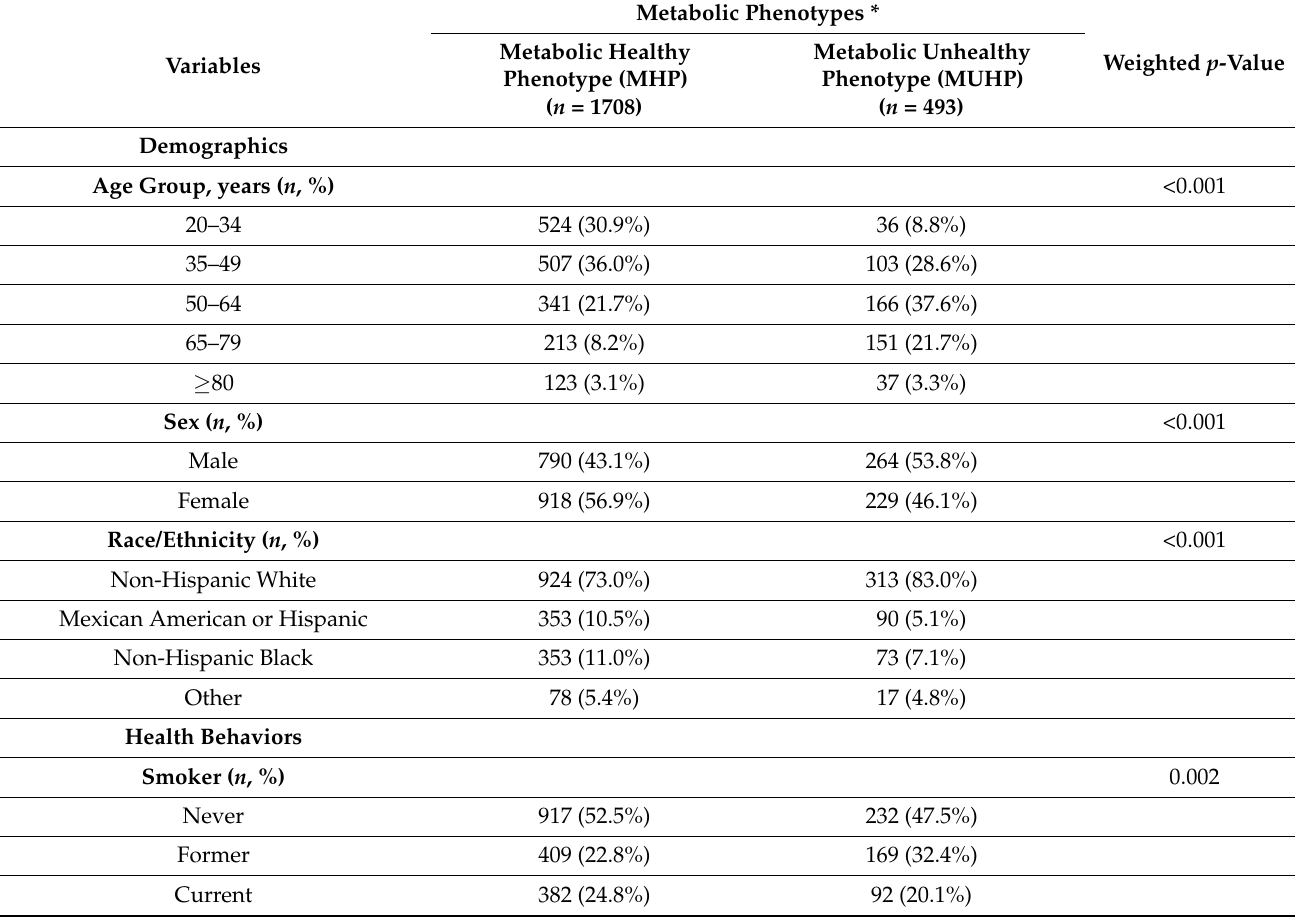
Table 1. Participant demographics, health behavior, and metabolic characteristics by metabolic phenotypes.